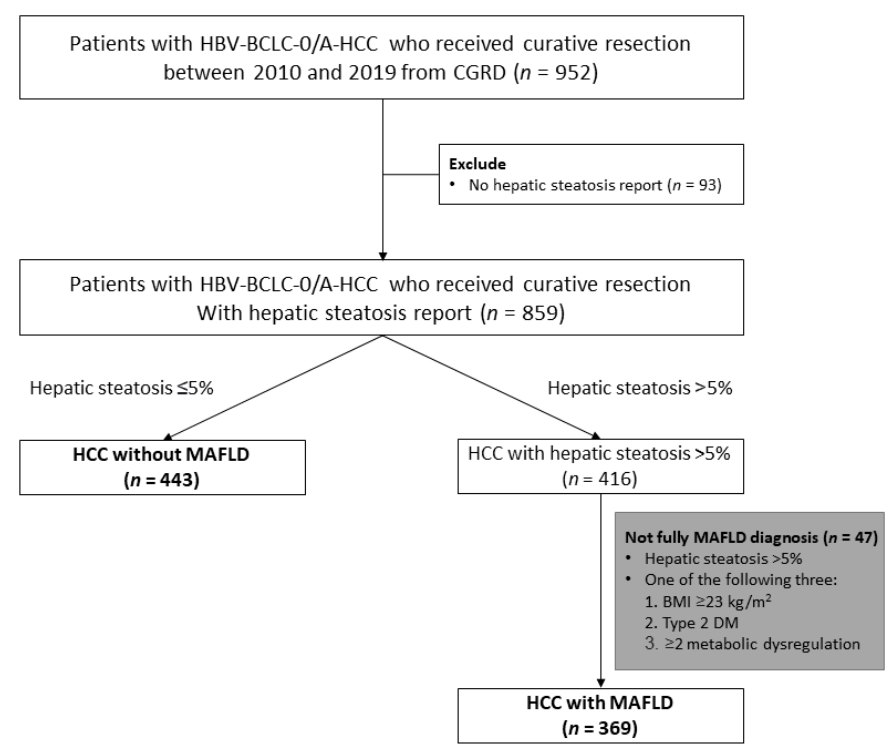
Figure 1. Patient selection flow diagram. Bold font is eligible for this analysis.